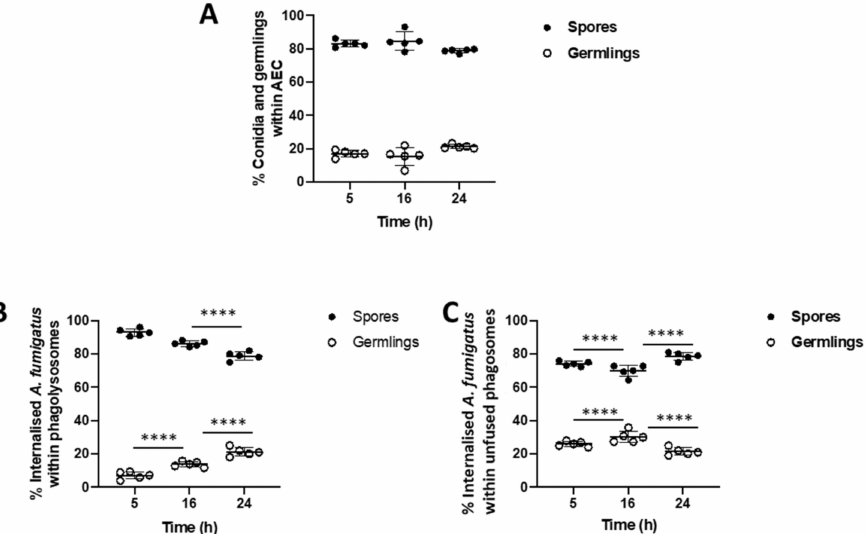
Figure 3. Suboptimal lysosome fusion permits A. fumigatus germination within the airway epithelium. ( A ) Proportion of A. fumigatus spores and germlings within A549 alveolar epithelial cells. ( B ) Propor- tion of internalized spores and germlings within phagolysosomes of A549 cells. ( C ) Proportion of internalized spores and germlings within unfused phagosomes of A549 cells. Data represents mean and standard deviation of five biological replicates. Differences in proportions between time points for spores and germlings were independently tested using the Fischer Exact Test. **** p <